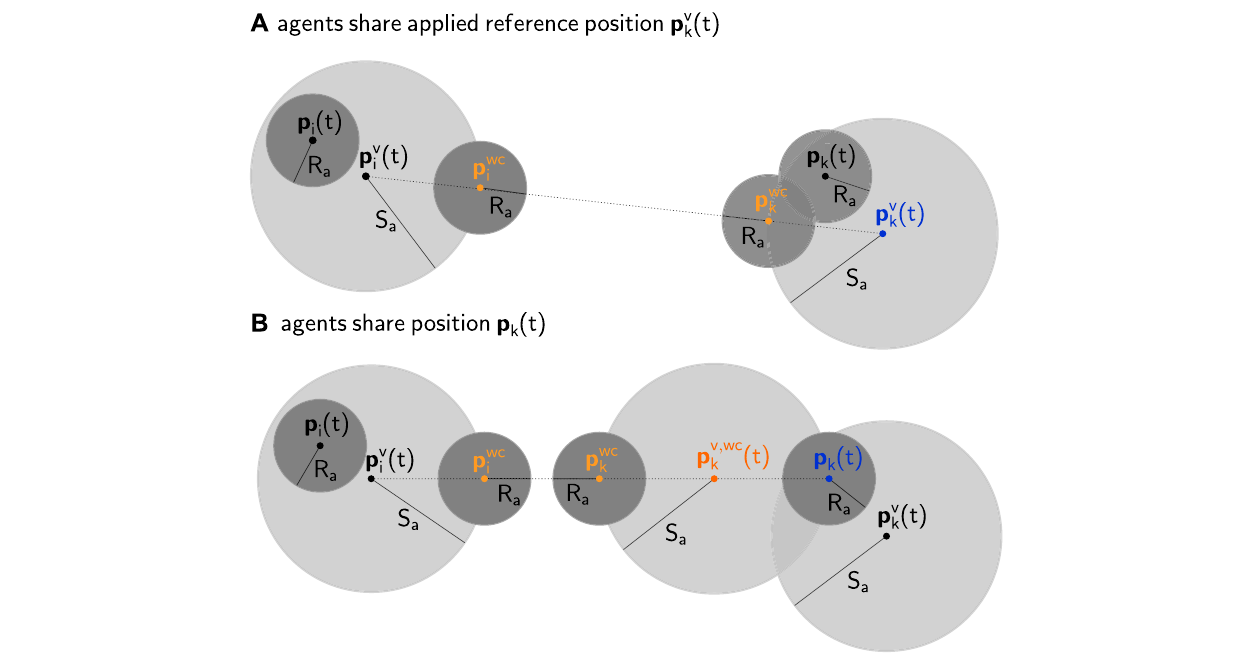
FIGURE 6 | Geometric 2D representation of distributed collision avoidance between two pre-stabilized agents i (left) and k (right) with safety radii R a (dark gray disks), drawn from the perspective of agent i . The current position of each agent is p i ( t ) , p k ( t ) , whereas their current reference is p v i ( t ) , p v k ( t ) . Due to the auxiliary constraint (38) (in light gray), accounted for in the DSM, the smallest possible distance between the two agents is equal to the distance between their worst-case future positions p wc i , p wc k . Together with the auxiliary constraint (37) , which is enforced by the NF, this ensures the collision avoidance constraint (10) . If the agents share theirreferences( case A ),agent i cancompute the worst-case future positionofagent k based on its currentreference p v k ( t ) . Ifagent i only knowsthe position ofagent k ( case B ), it must use p k ( t ) to compute the worst-case current reference p v , wc k ( t ) and must then compute the worst-case future position based on p v , wc k ( t )